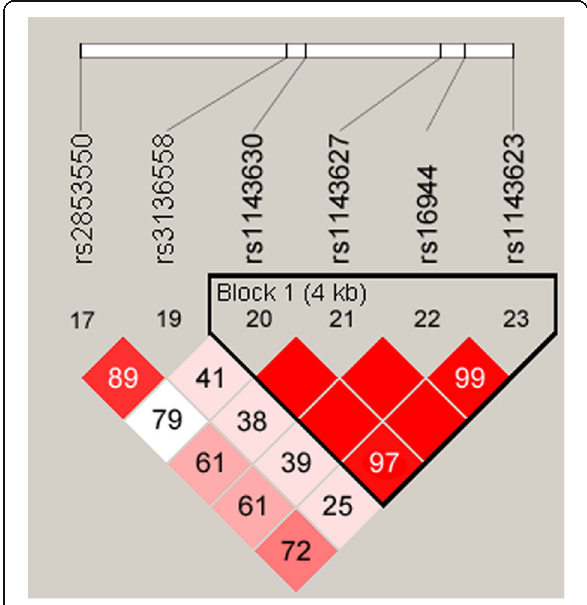
Fig. 1 Illustration of the haplotype block. Four IL-1B polymorphisms (rs1143630-rs1143627-rs16944-rs1143623) mapped to a 4-kb LD block. The red squares in the IL-1B LD block indicate significant linkages between the four SNPs. The numbers in squares are the values of D ’ . Different numbers show the degree of LD of SNPs. The bright red squares with no number in the middle have the D ’ of